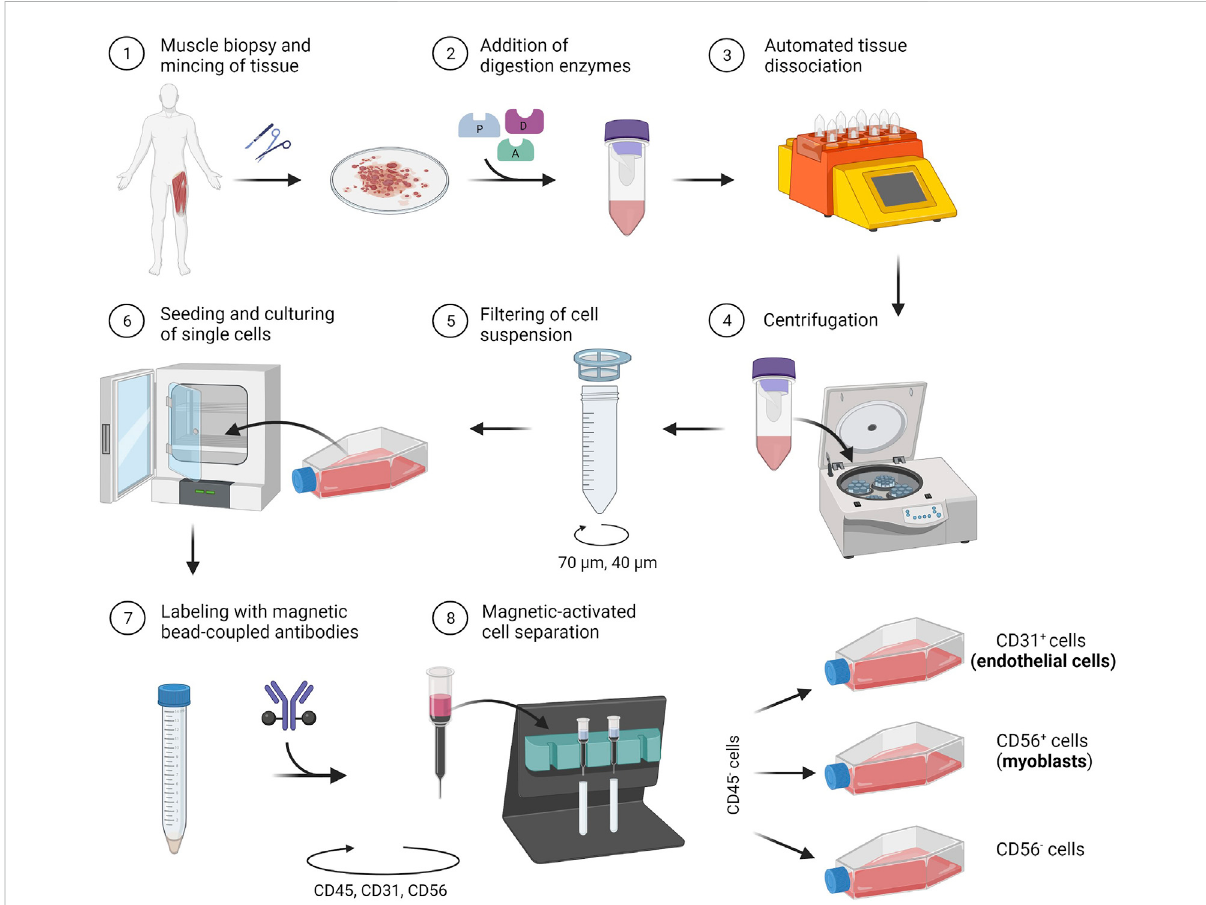
FIGURE 1 Schematic representation of the developed protocol for the co-isolation of microvascular endothelial cells (CD31 + ) and satellite cell-derived myoblasts (CD56 + ) from human skeletal muscle